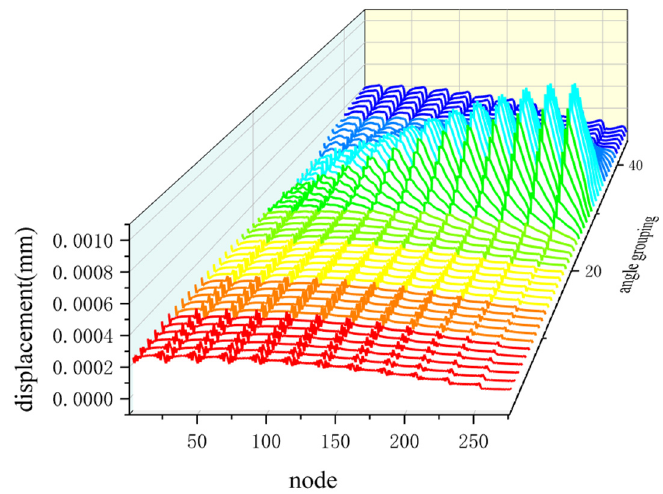
Figure 14. Plus node displacement at different angles output after program optimization.